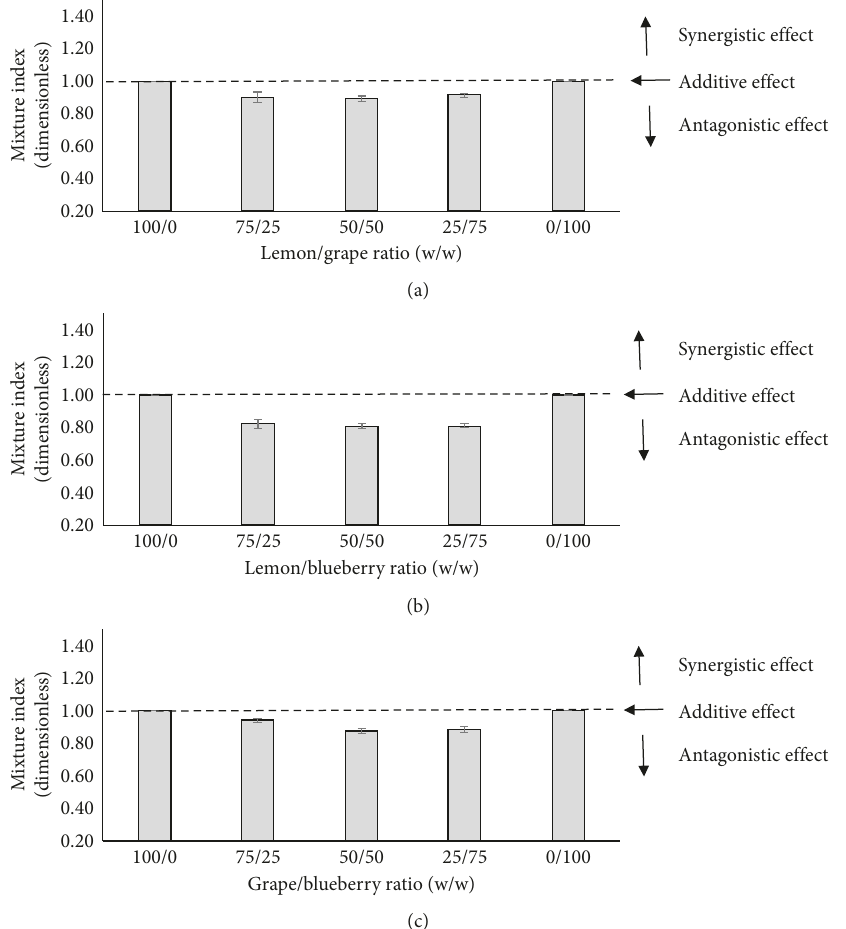
Figure 2: Different ratios (w/w) evaluated when combining fruits by SWV for